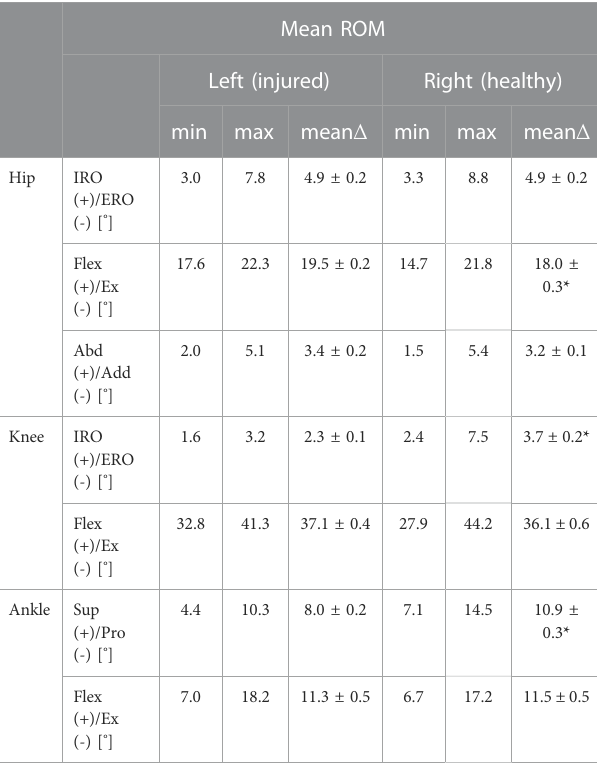
TABLE 1 Range of motion with global minima (min) and maxima (max) and its meanrange(mean Δ )oftheinjuredleftlegandthehealthyrightlegoverallsteps (n = 30) for each joint (hip, knee and ankle joint) and its different directions of movement such as internal rotation (IRO)/external rotation (ERO), fl exion ( fl ex)/ extension (ex) and supination (sup)/pronation (pro) of the patient on the treadmill independent from the gait velocity. Mean ± SEM; * p < 0.05 vs.